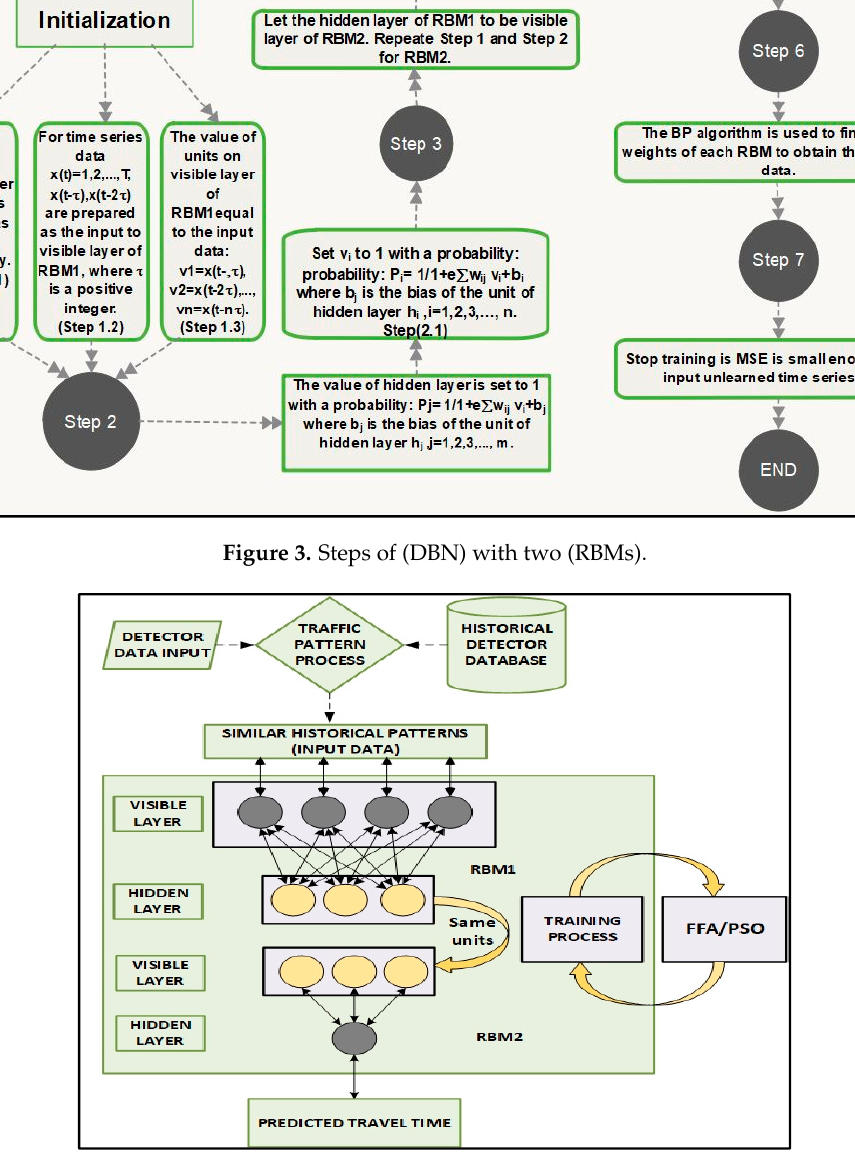
Figure 4. Proposed DRBM ‐ FFA prediction model.